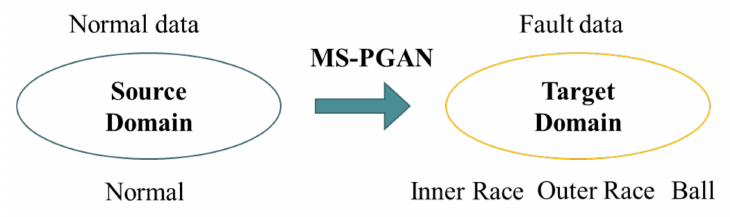
Figure 4. The process of transfer